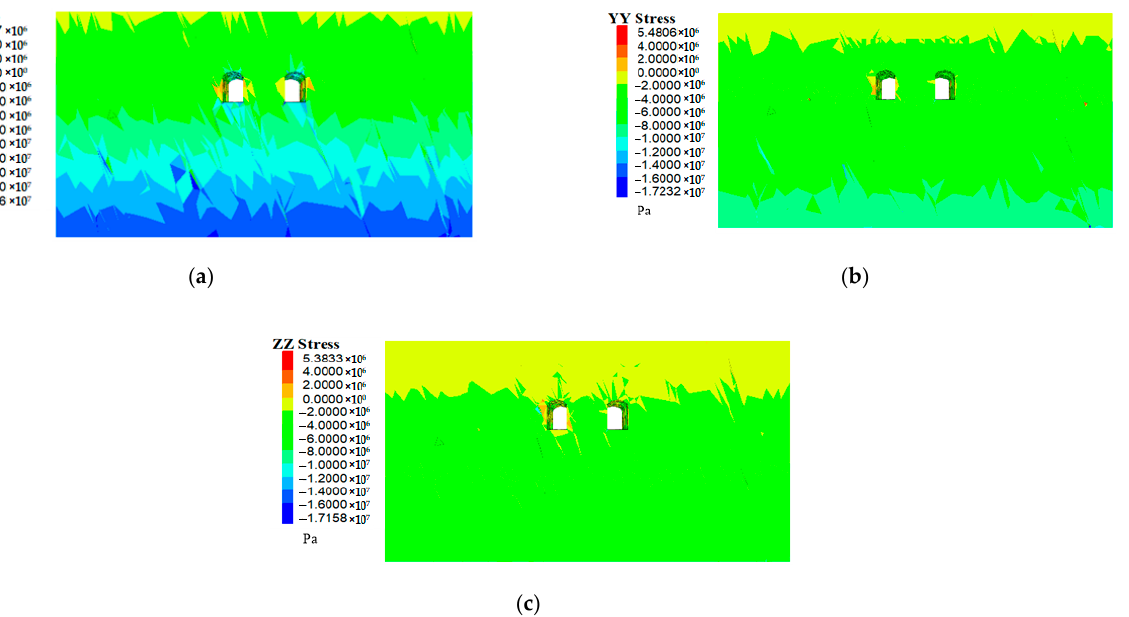
Figure 21. Stress contours of surrounding rock of cavern in different directions: ( a ) X-axis direction, ( b ) Y-axis direction, ( c ) Z-axis direction (7 MPa).